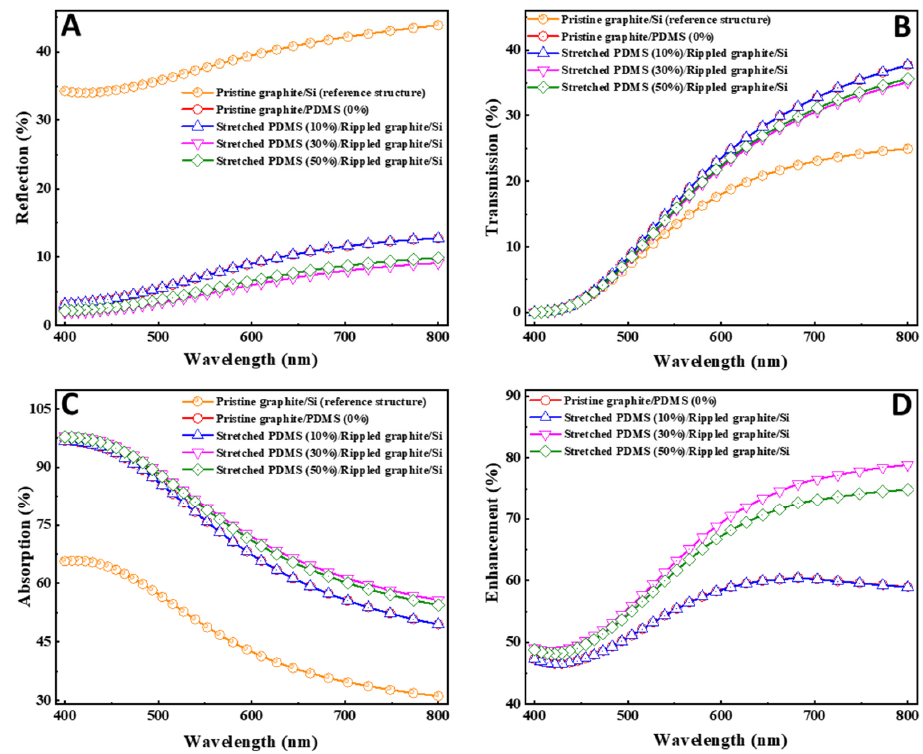
Figure 5. Lumerical finite-difference time-domain (FDTD) computation for the optical characteristics of the spectra of ( A ) reflection, ( B ) transmission, ( C ) absorption, and ( D ) light absorption enhancement of optical sensing devices based on rippled graphite nanofilm under different stretch:release ratios (0%, 10%, 30%, and 50%).